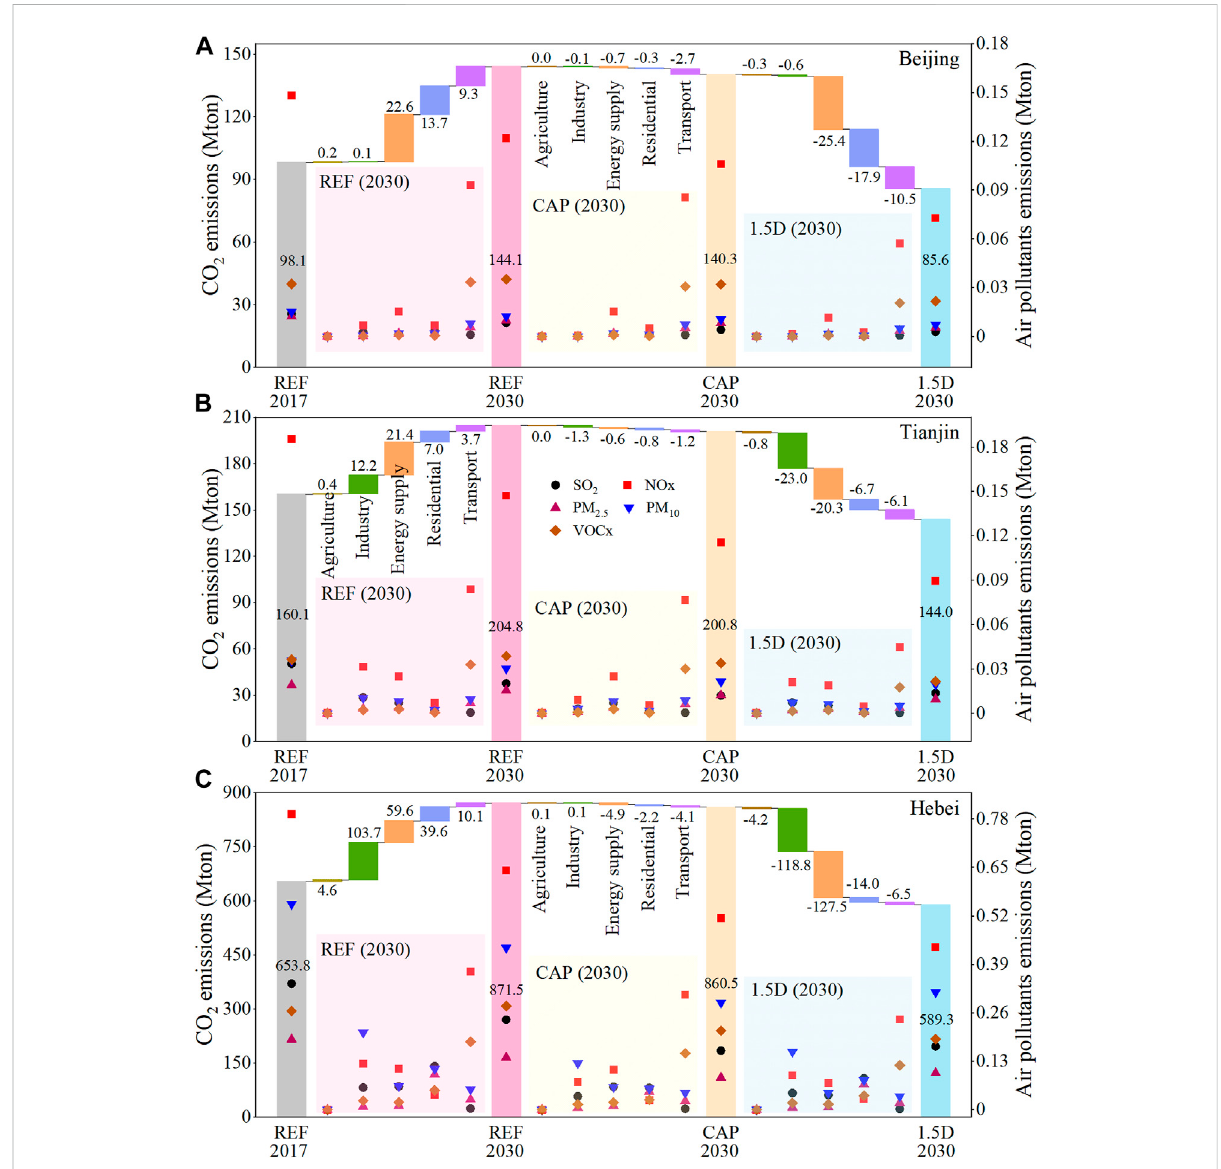
FIGURE 5 CO 2 emissions of three scenarios from different sectors in Beijing (A) , Tianjin (B) and Hebei (C) . Light pink shaded portions are the air pollutants emissionineachsectorunderREFscenarioin2030,lightyellowshadedportionsaretheairpollutantsemissionineachsectorunderCAPscenarioin 2030, light blue shaded portions are the air pollutants emission in each sector under 1.5D scenario in